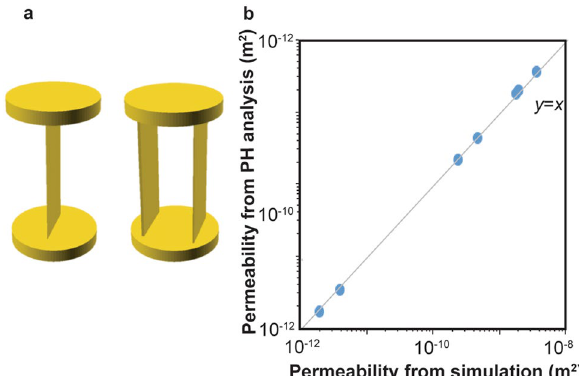
Figure 5. Validation with simple models. ( a ) One or two fracture penetrating the model. The top and bottom are the inlet and the outlet. ( b ) Comparison of permeability between persistent homology (PH) analysis and direct simulation. The calculated permeability is listed in Table